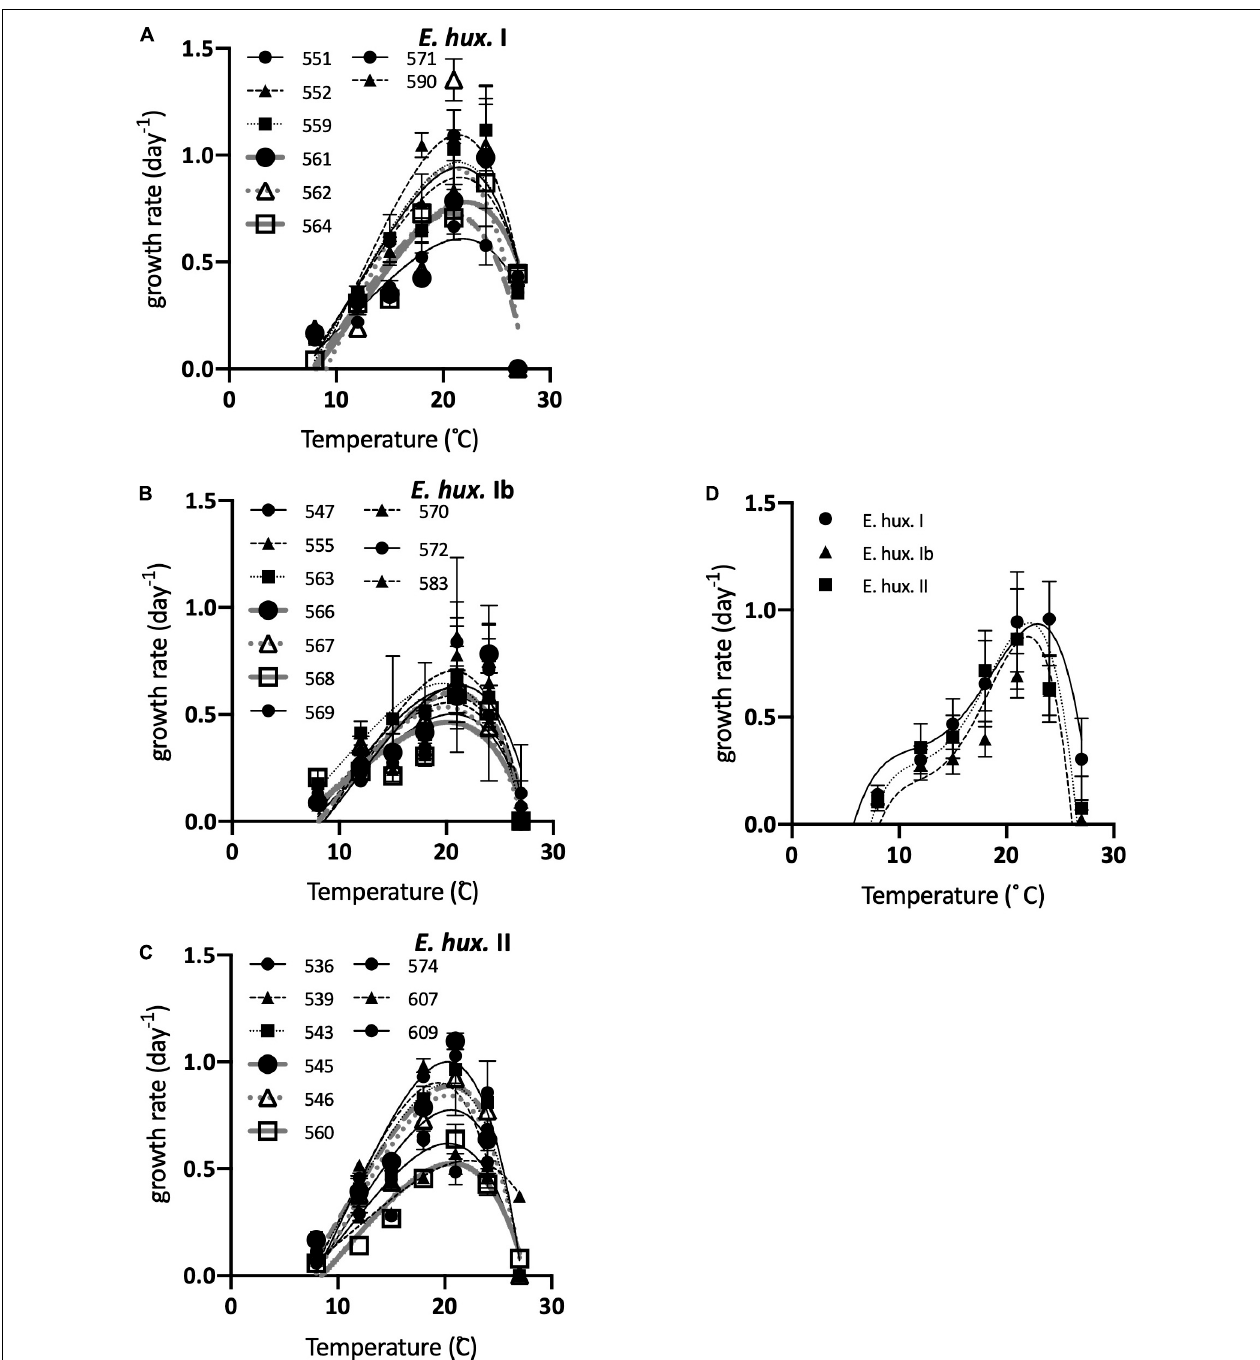
FIGURE 7 | Thermal performance curves for growth for all strains in Experiment 2, with the corresponding fits to the Norberg equation overlaid. (A) Haplogroup I. (B) Haplogroup Ib (C) Haplogroups II. (D) The corresponding average TMV curves overlaying the haplogroup-specific average values of growth rate at each temperature (solid line is haplogroup I, dashed line is haplogroup Ib, dotted line is haplogroup